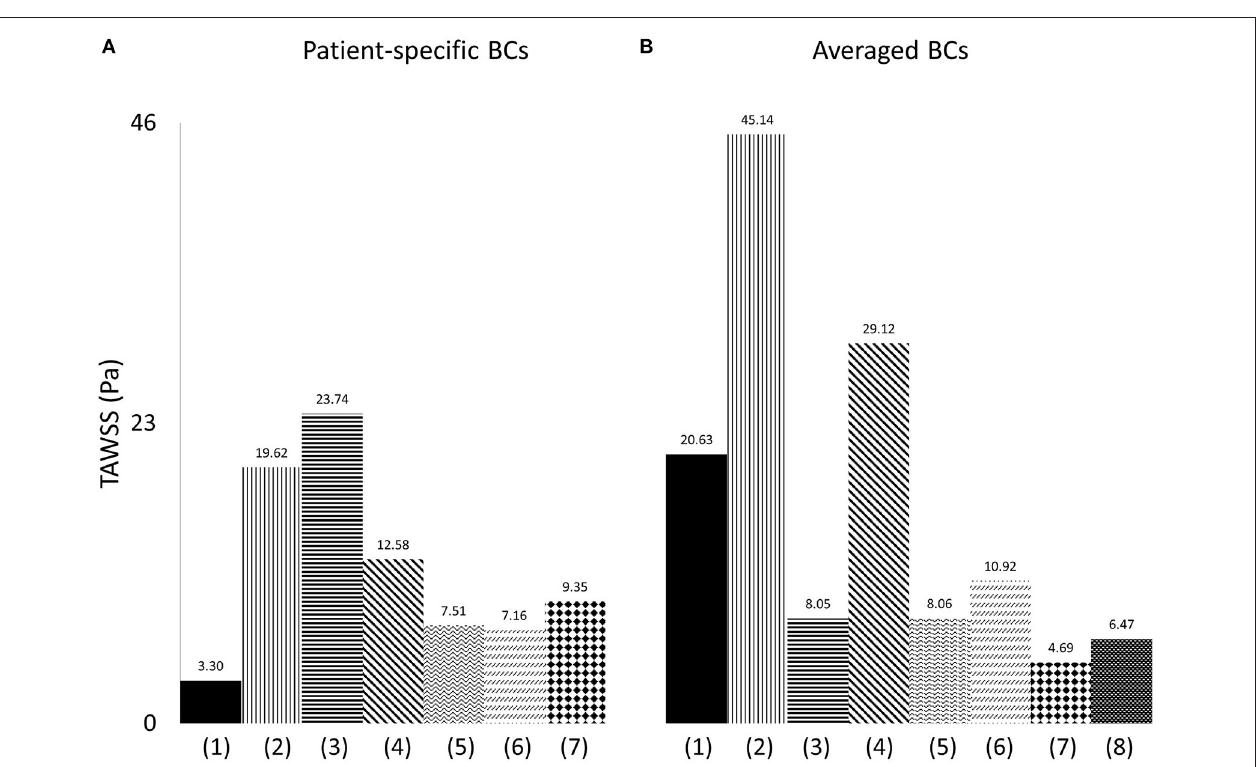
FIGURE 10 | Time-averaged wall shear stress (TAWSS) plot, derived from the TAWSS values of eight points located along the perimeter of cross-sections ( α ) and ( γ ), and presented in Pascal (Pa), when (A) patient-specific, and (B) averaged boundary conditions are specified, and for (1) model 1; (2) model 2; (3) model 3; (4) model 4; (5) model 5; (6) model 6; (7) model 7; (8) the average model.